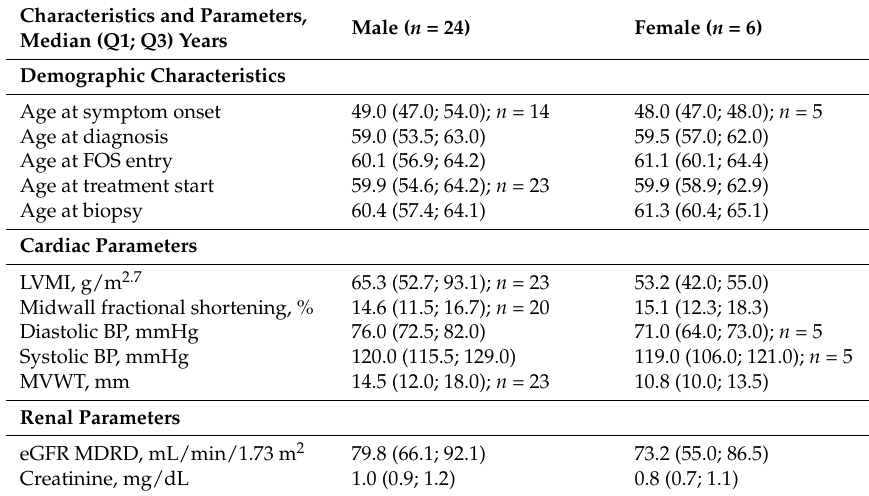
Table 1. Demographic characteristics and cardiac and renal parameters within ± 6 months of the biopsy